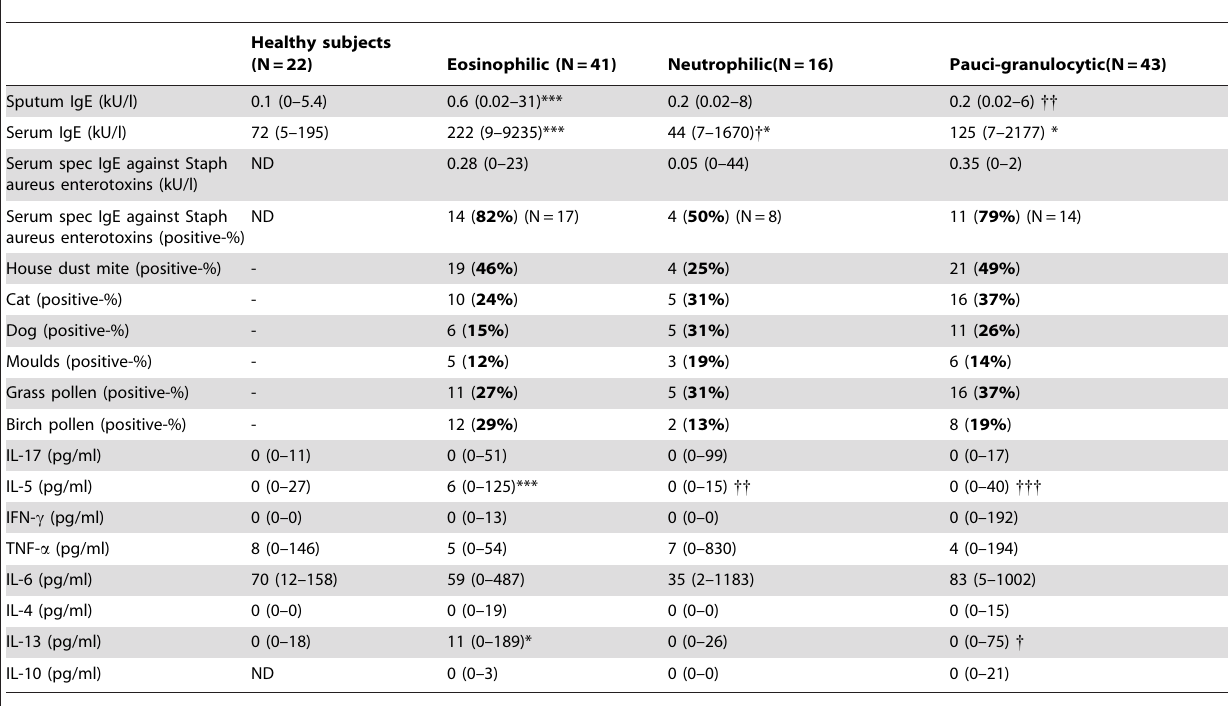
Table 2. Total sputum and serum IgE, serum specific IgE and sputum cytokine levels according to sputum cellular phenotype.